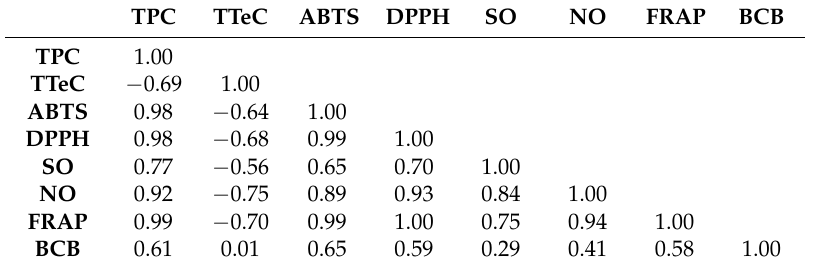
Table 2. Pearson correlation coefficients calculated among tested Senecio clivicolus extract and fractions. TPC TTeC ABTS DPPH SO NO FRAP BCB TPC 1.00 TTeC − 0.69 1.00 ABTS 0.98 − 0.64 1.00 DPPH 0.98 − 0.68 0.99 1.00 SO 0.77 − 0.56 0.65 0.70 1.00 NO 0.92 − 0.75 0.89 0.93 0.84 1.00 FRAP 0.99 − 0.70 0.99 1.00 0.75 0.94 1.00 BCB 0.61 0.01 0.65 0.59 0.29 0.41 0.58